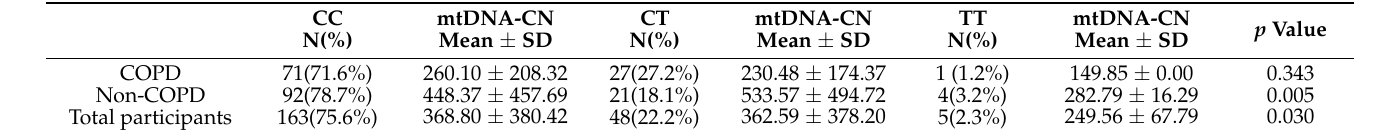
COPD group, non-COPD group or total